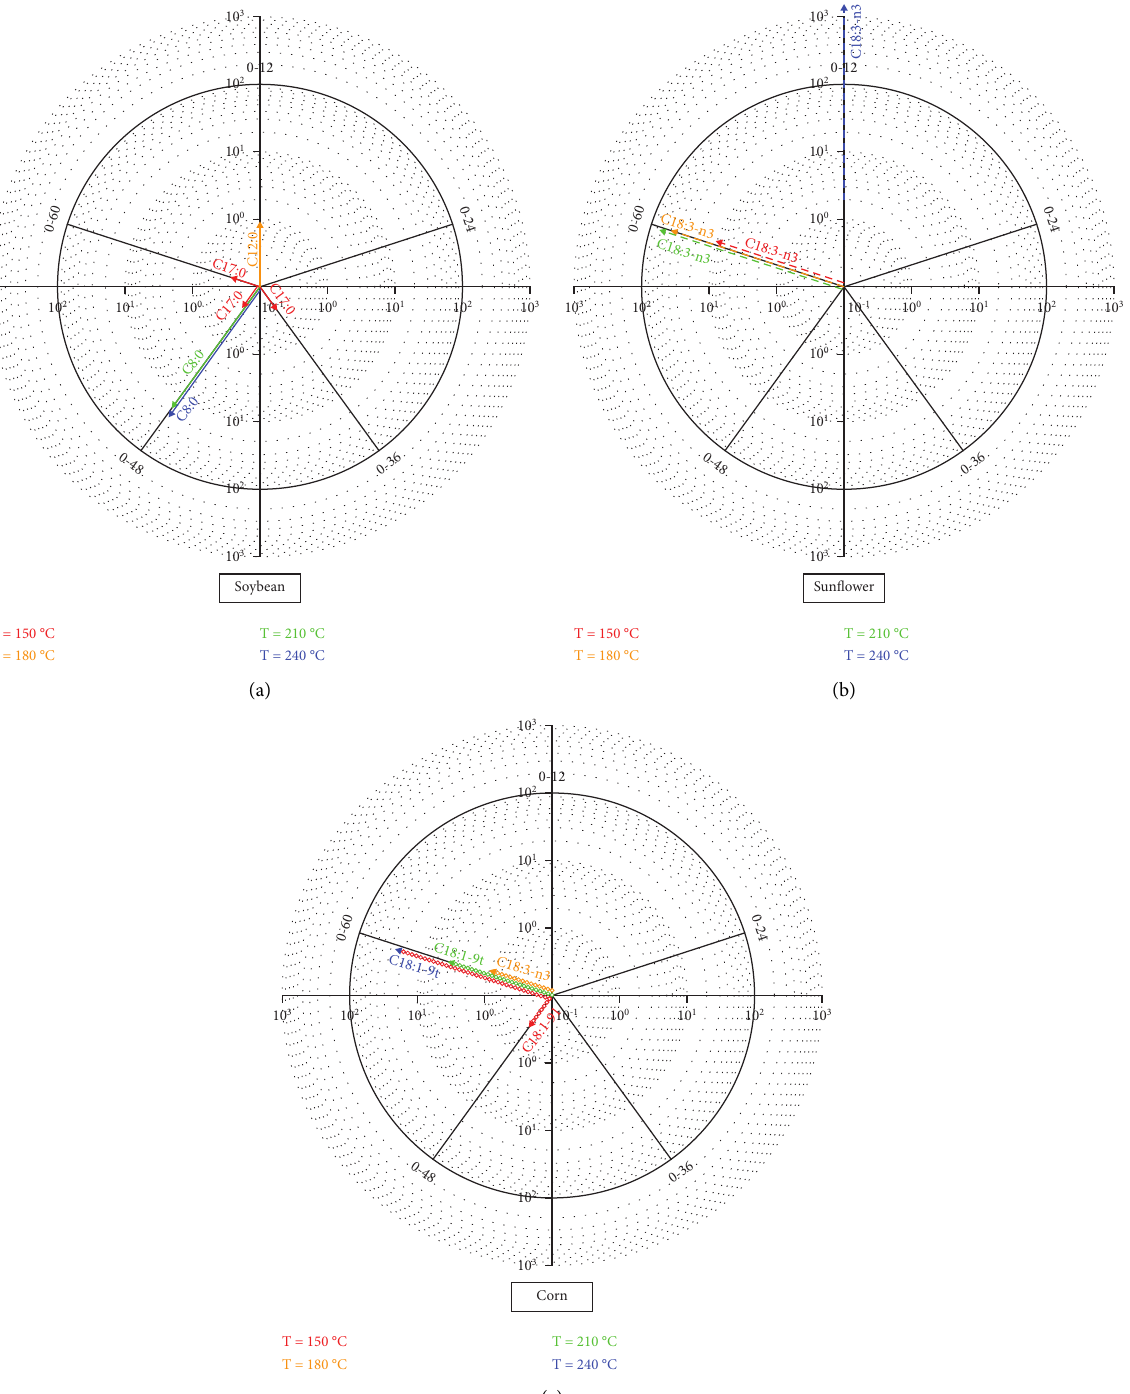
Figure 2: Heating time variations (in hours) leading to maximum change rate of fatty acids at different temperatures per species: (a) soybean, (b) sunflower, and (c) corn. The vector length and direction designate the change rate of the fatty acid and the heating time variation, respectively. The fatty acid compositions are written as supplementary explanatory